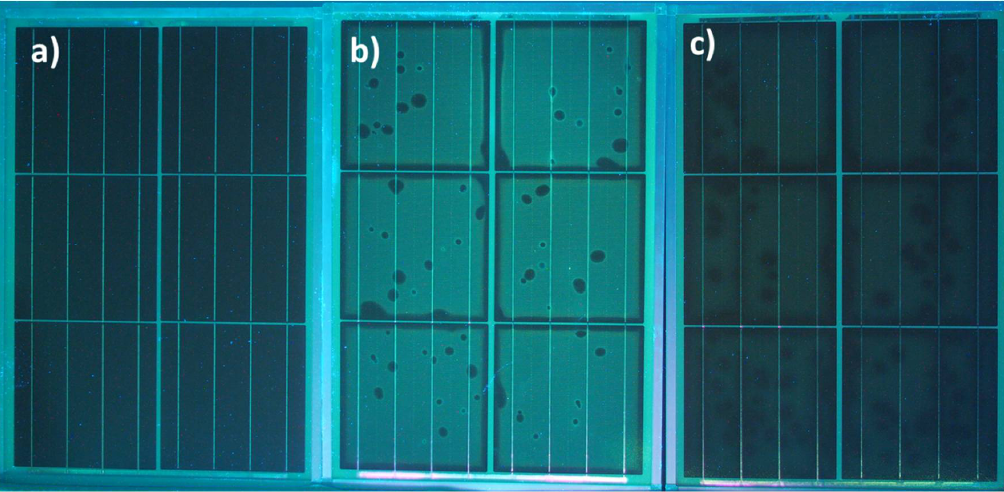
Figure 5. UV-F images of three test modules with micro-cracks: ( a ) one in the original state (stabilized); ( b ) one after exposition to artificial sunlight (1000 W/m 2 ) for 1000 h; and ( c ) one after natural storage for 1.5 years.